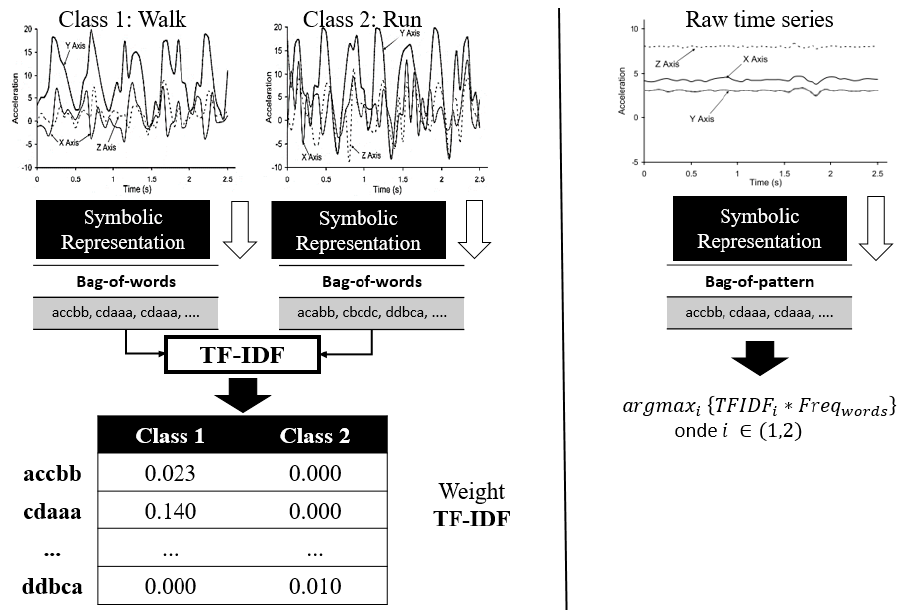
Figure 10. Example of the data processing steps of the SAX-VSM algorithm.